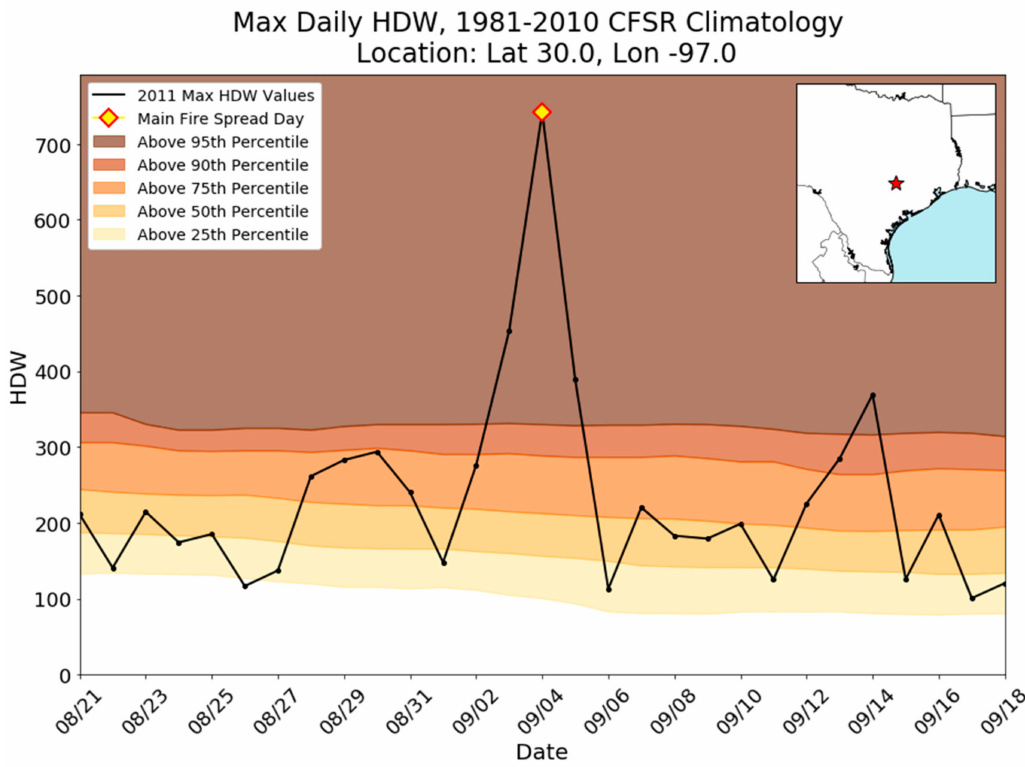
Figure 5. As in Figure 4, but for the Bastrop County Complex (grid point 30.0 ◦ N, 97.0 ◦ W; 29-day period centered on 4 September). The black trace represents HDW values calculated from CFSR for the same 29-day period in